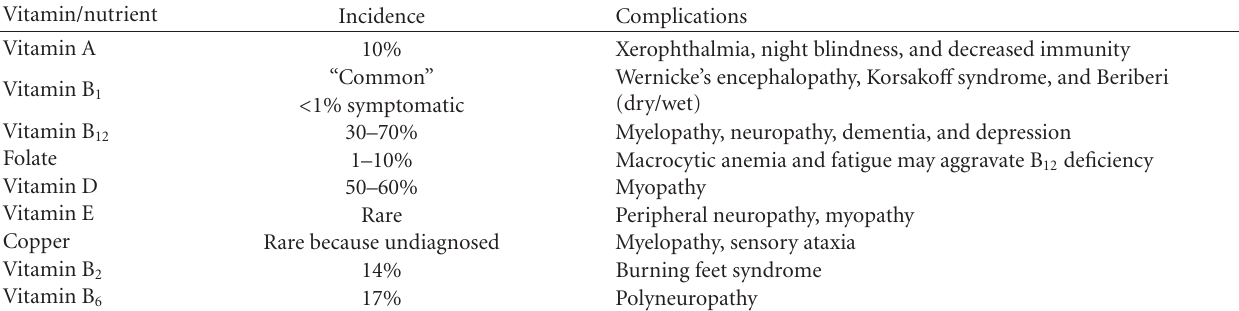
Table 3: Specific neurological complications associated with vitamin deficiencies after bariatric